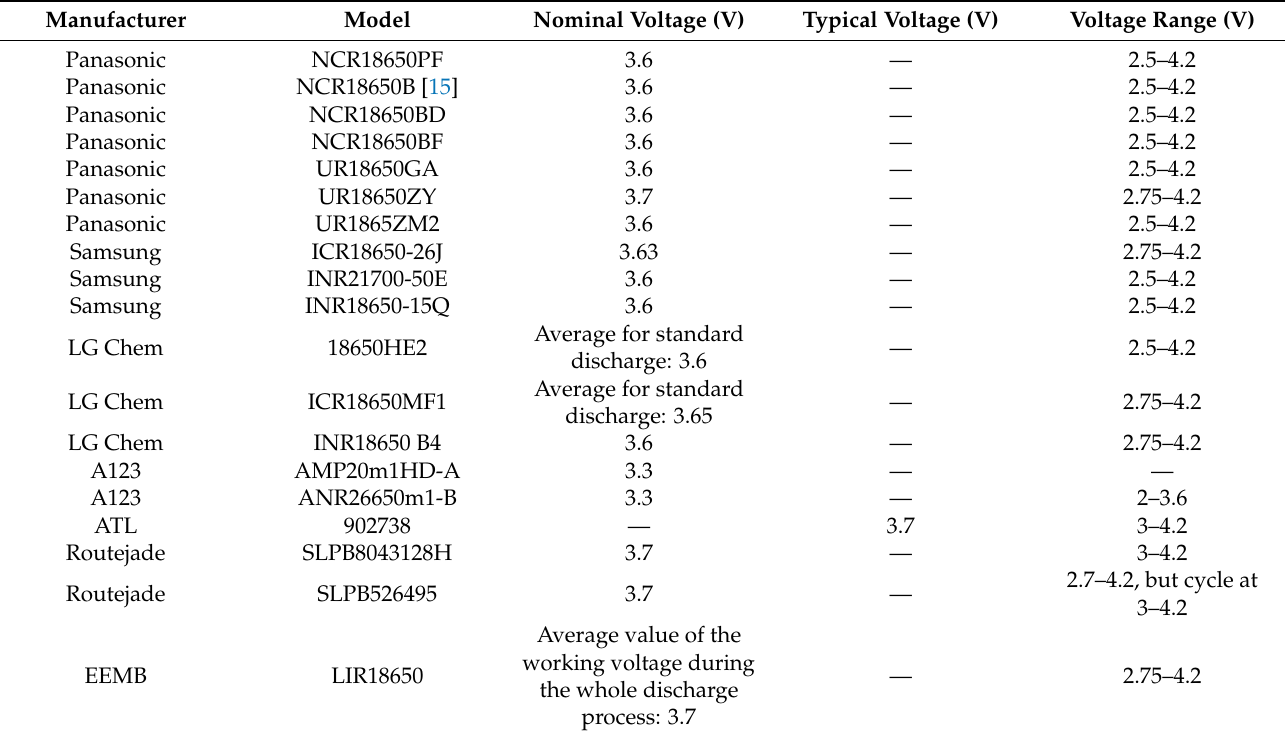
Table 4. Voltage terms used in